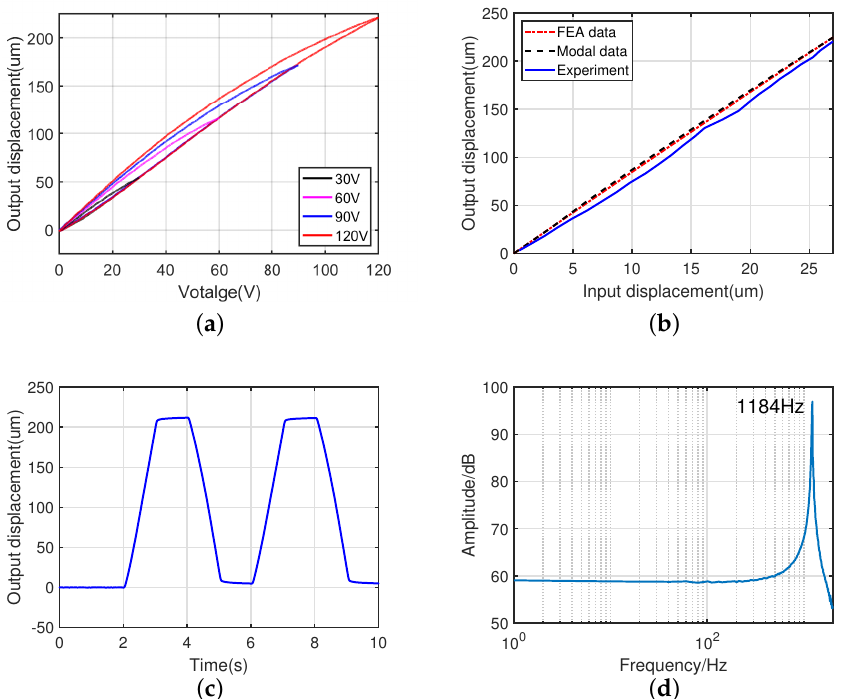
Figure 16. Experimental results of the machined prototype. ( a ) Hysteresis experiment. ( b ) Amplifica- tion ratio test. ( c ) Stroke range test. ( d ) Resonant frequency